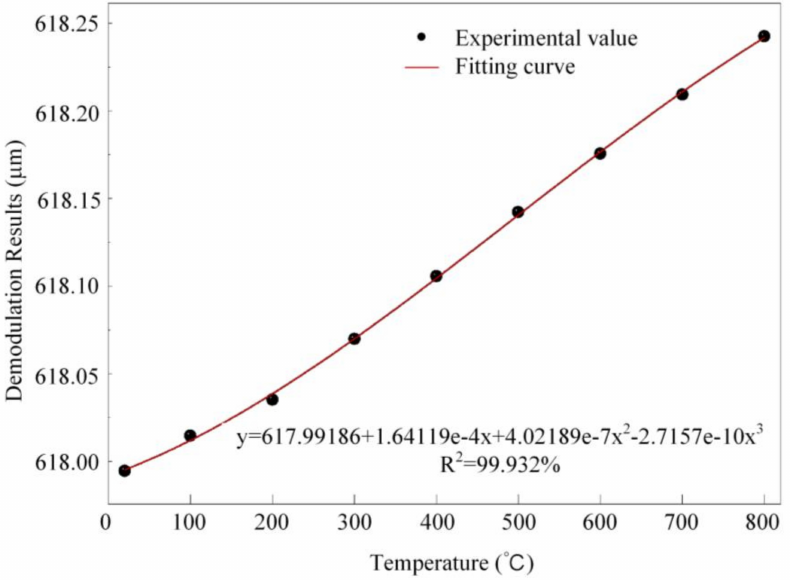
Figure 5. Temperature drift of FOFPA from 20 ◦ C to 800 ◦